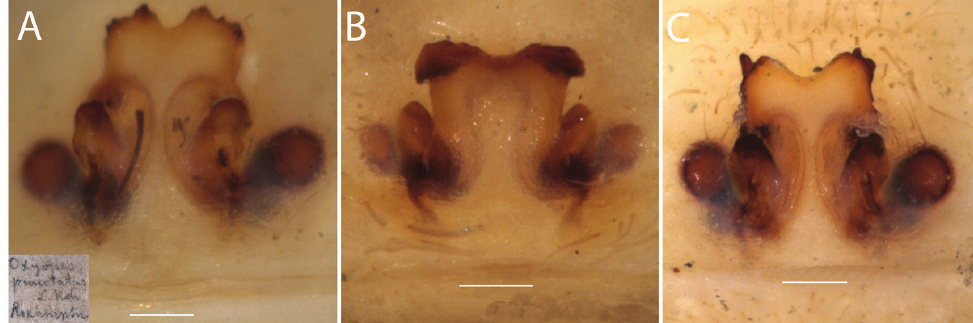
Figure 15. Oxyopes punctatus L. Koch, 1878, epigynes of female paralectotypes (ZMH- A0000016): A , female paralectotype described; B , second female; C , third female. Scale bars: epigyne 0.1